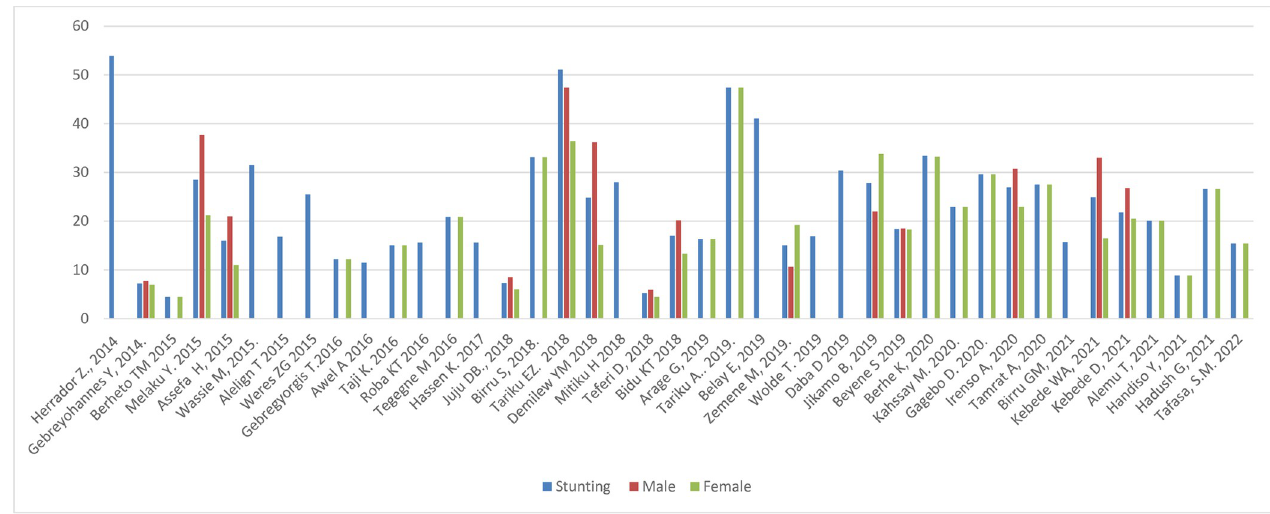
Fig 6. Trends in adolescent stunting by sex in Ethiopia over the last 7 years.